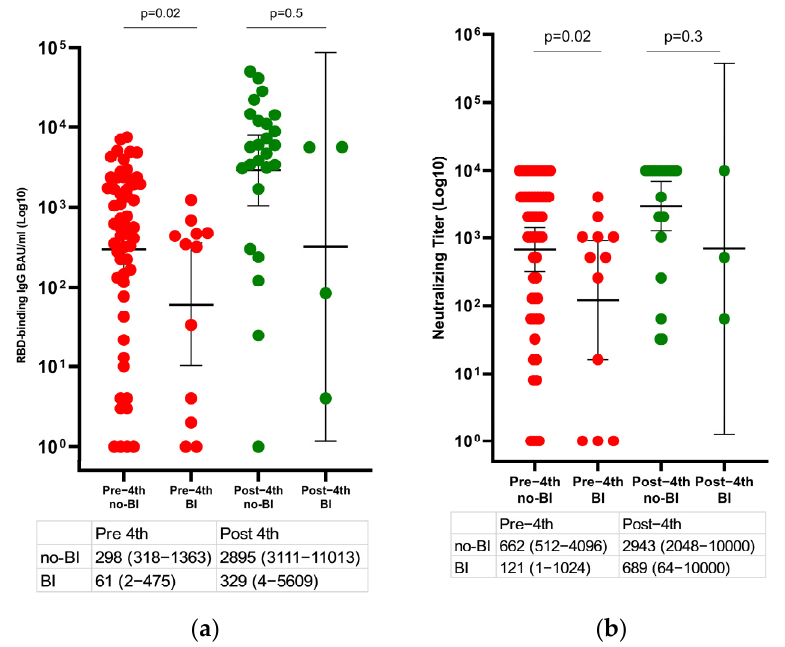
Figure 5. Changes in the humoral immune response after the third and the fourth vaccine doses among liver transplant recipients with and without a breakthrough infection. ( a ) Scatter plot pre- senting changes in anti-RBD IgG and ( b ) SARS-CoV − 2 pseudo-virus neutralizing antibody titers before and after the fourth vaccine dose (the pre-fourth was 131 days (IQR, 129–137 days) after the third dose and the post-fourth was 29 days (IQR, 25–33 days) after administration of the fourth vaccine dose). Differences in paired samples were calculated using the Wilcoxon matched-pairs signed-rank test. The horizontal line indicates geometric mean values with a 95% confidence interval. BI, breakthrough infection.